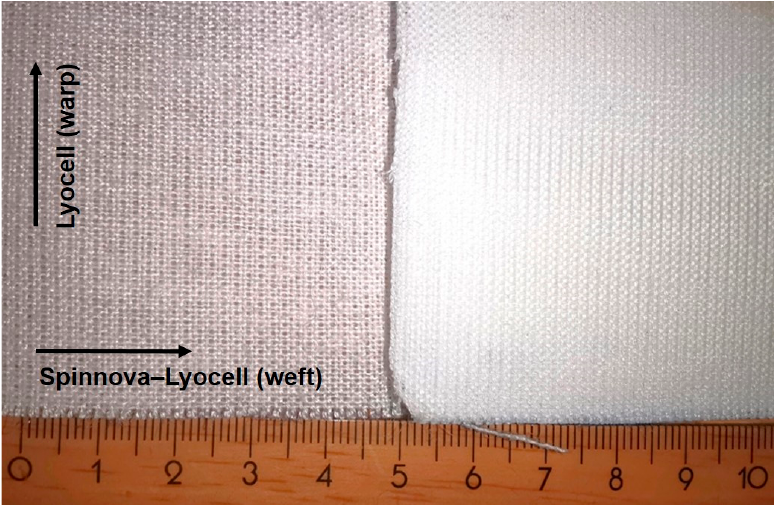
Figure 1. Initial material: Spinnova-Lyocell is seen on the left and produced ACC on the